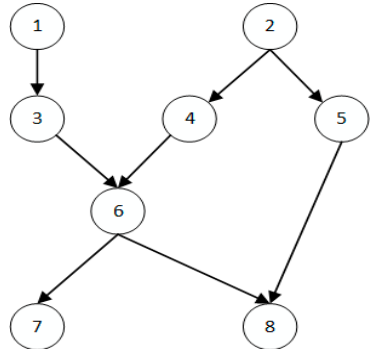
Figure 4. Standard Figure 4. Standard ASIA.